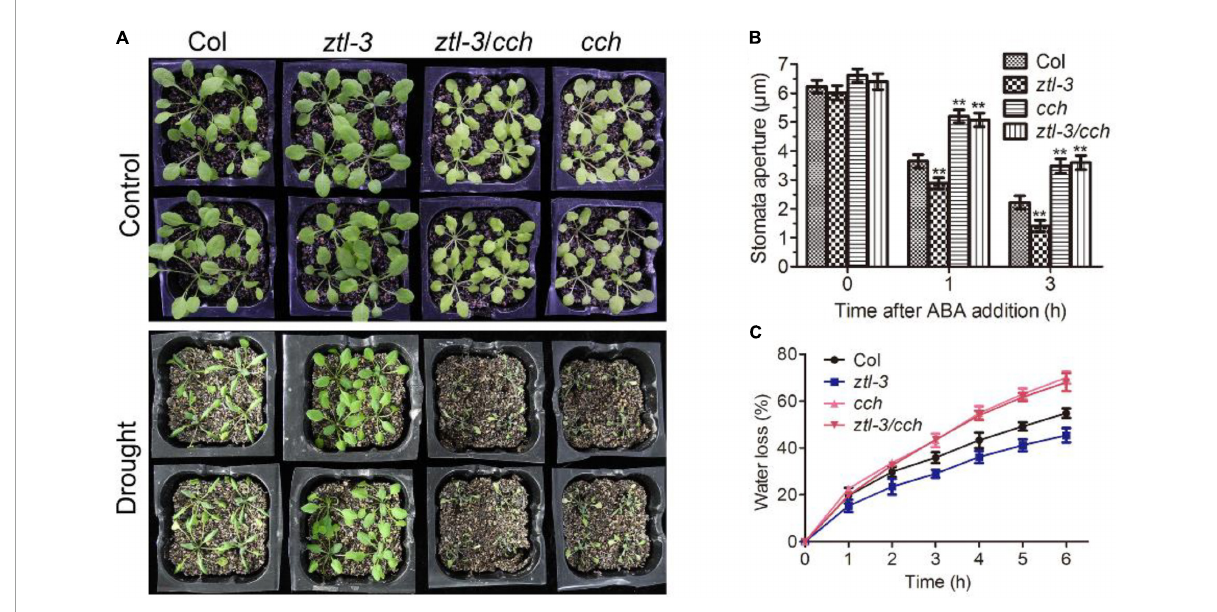
FIGURE6 Disruption of CHLH suppresses ABA hypersensitivity of ztl-3 mutant. (A) Whole-plant status in drought tolerance assay for Col, ztl-3 , ztl-3 / cch and cch plants. Plants were well watered (Control) or drought stressed (Drought) by withholding water for 2 weeks or re-watered for 2 d (Re-watered). The experiments were repeated five times with similar results. (B) Stomatal apertures of Col, ztl-3 , ztl-3 / cch and cch plants. Stomatal apertures were measured before ABA treatment and 1 or 3 h after ABA treatment. Data are the means ± SE from four independent experiments with 60 apertures per genotype and per treatment (with significant differences at ** P < 0.01). (C) Water loss rates during a 6-h period from the detached leaves of Col, ztl-3 , ztl-3 / cch and cch plants. Each value is the mean ± SE of three biological